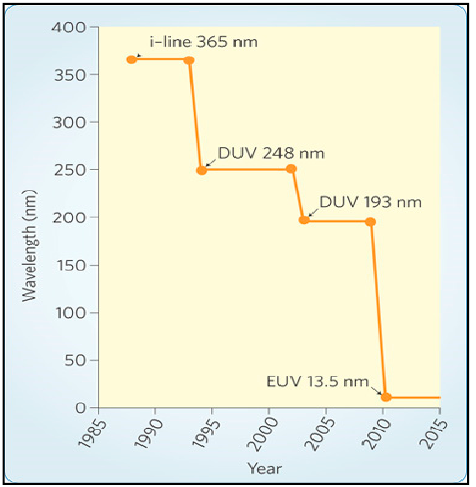
Figure 5. Evolution of light wavelengths used for optical inspection. The latest being super resolution deep ultraviolet (SR-DUV).